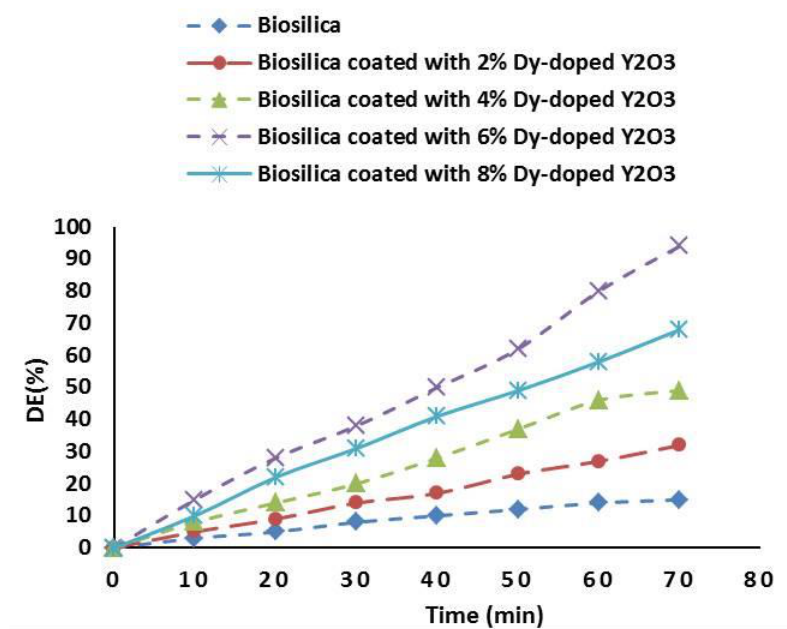
Fig.10. The decolorization of RB19 with different Dy 3+ content (catalyst loading 1.25 g/L)